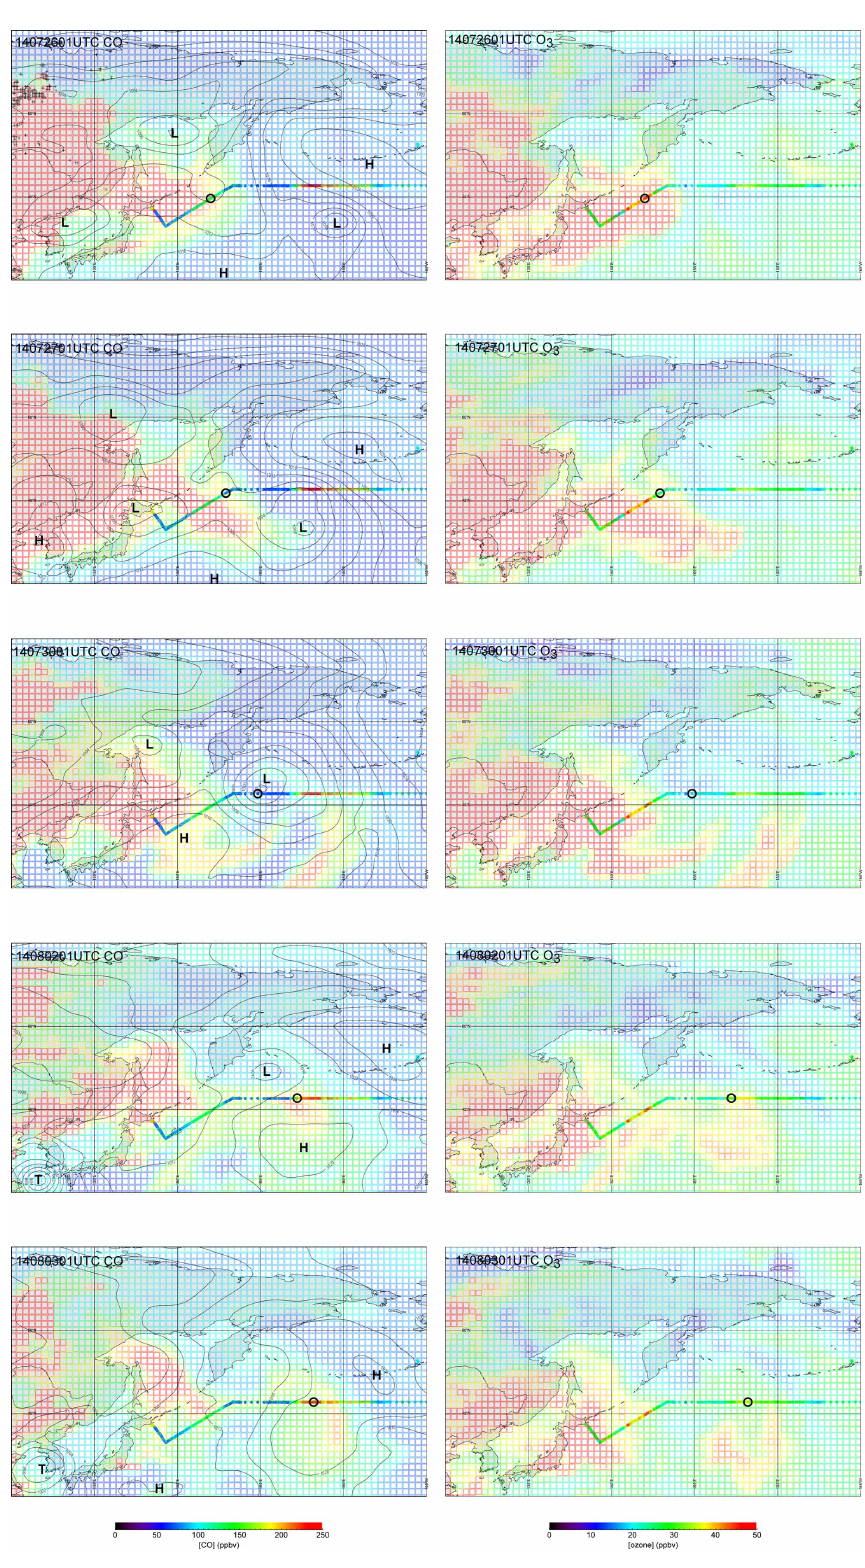
Figure 7. Temporal evolution of surface CO and O 3 distribution from TCR-2 (colored open squares) and from observations on R/V Mirai (all data; position of vessel is shown by black circle) during MR14-04 Leg 2 (from 26 July to 3 August 2014). Plus signs in the top-left panel show points with high carbon emissions from wildfires